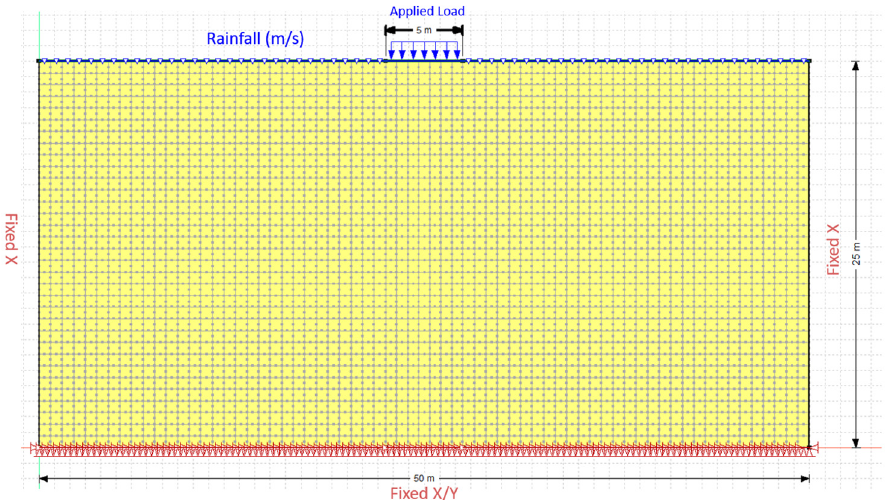
Figure 2. The 2D finite element (FE) model used in this